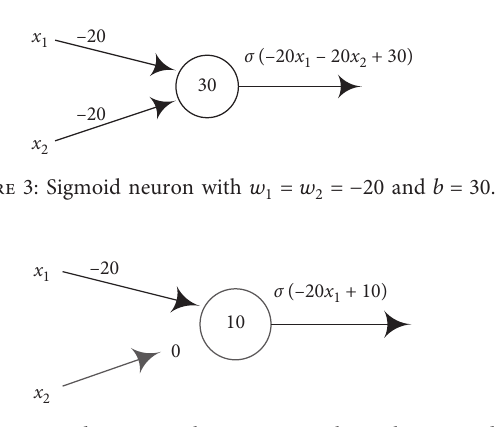
Figure 4: Sigmoid neuron with one input, with weight − 20, and an overall bias of 10.